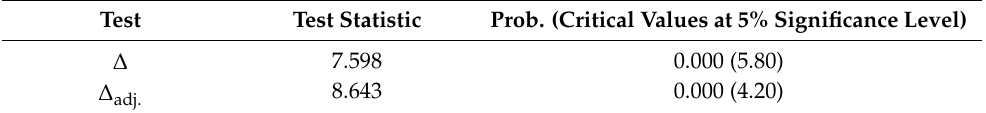
Table 4. Homogeneity tests’